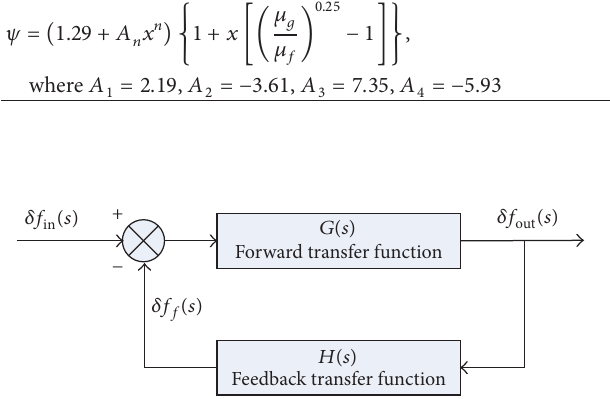
velocity and the total pressure drop in a channel.